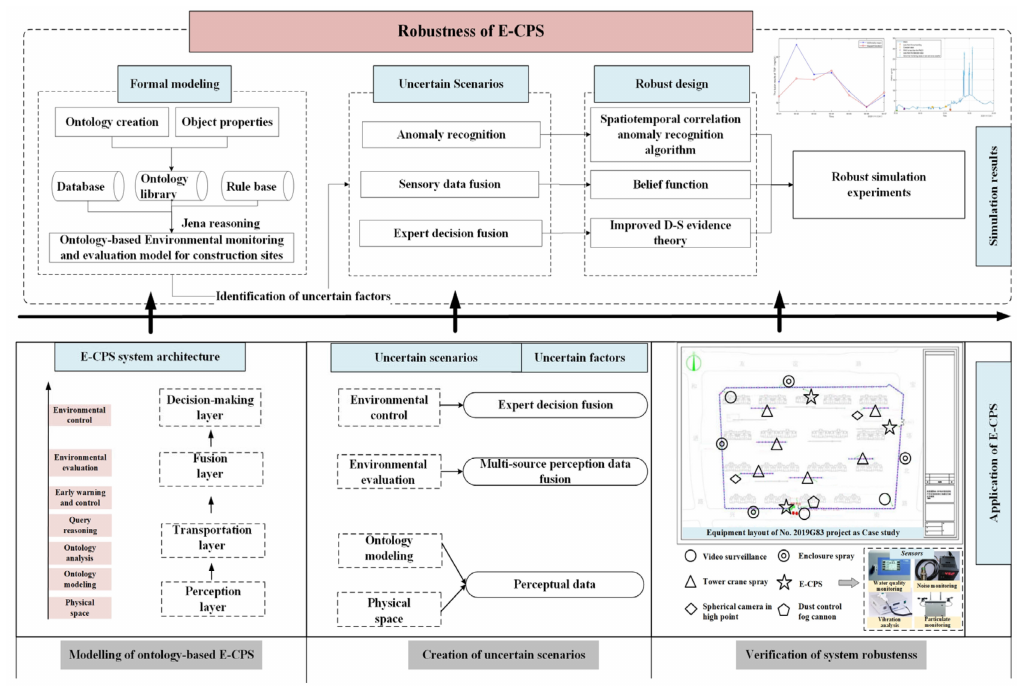
Figure 1. Overall research